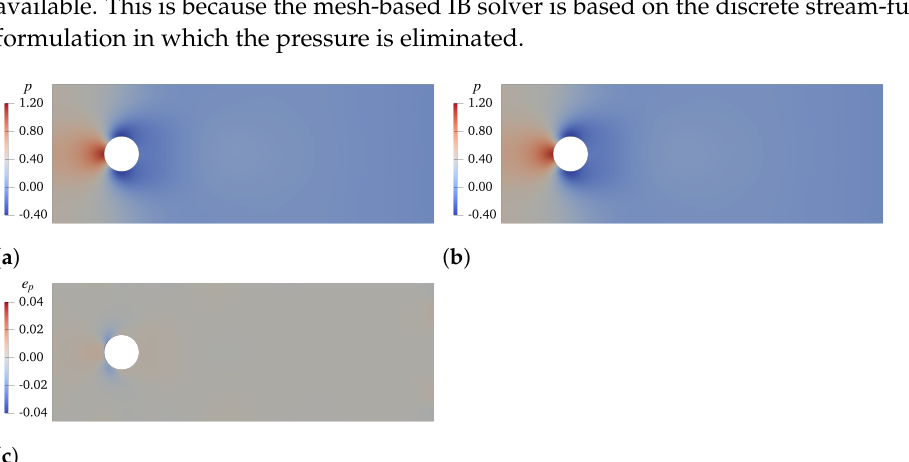
Figure 8. A comparison between the pressure contours obtained by using Fluent and IB-PINN. ( a ) pressure (Fluent); ( b ) pressure (IB-PINN); ( c ) difference in pressure between IB-PINN and Fluent. For the solution of IB-PINN, the interior region is filled with white color and the data are removed.